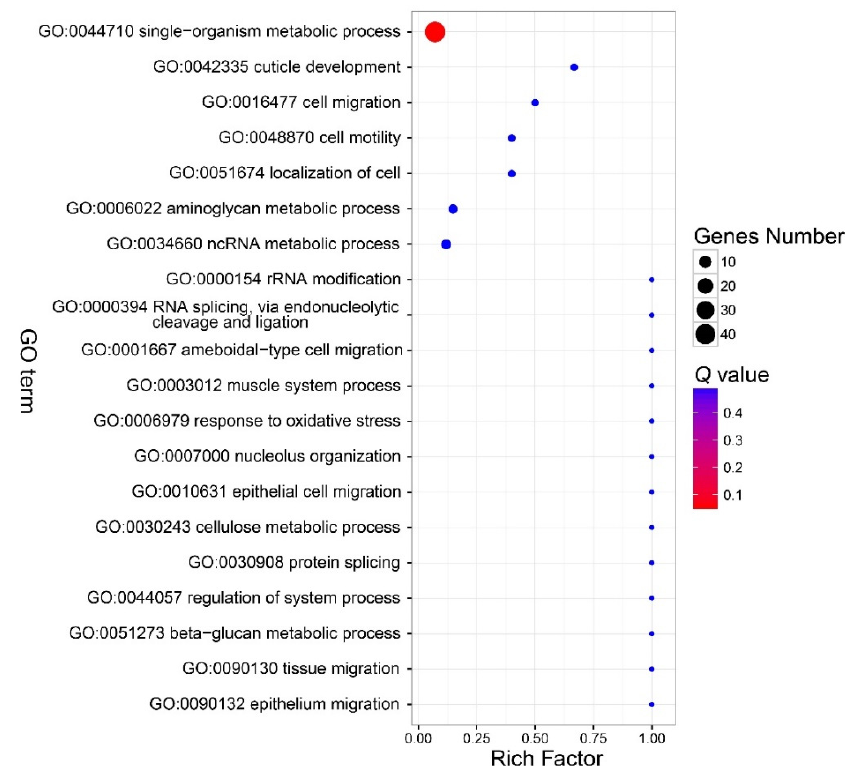
Figure 5. Bubble chart that shows the top 20 enriched GO terms in the biological process part.